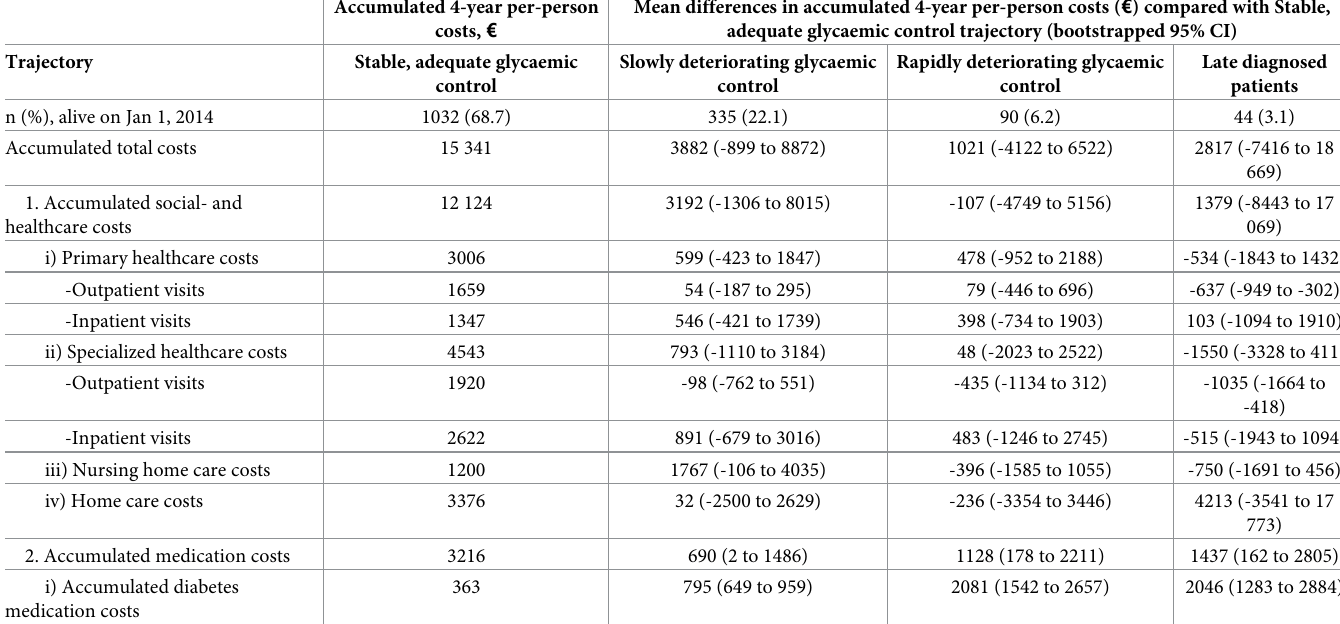
Table 3. Absolute accumulated 4-year per-person healthcare costs (euros, € ) for the Stable, adequate glycaemic control trajectory. Mean differences in accumulated 4-year per-person healthcare costs between HbA1c trajectories with bootstrapped 95% confidence intervals (Stable, adequate glycaemic control trajectory as a reference). All costs are Kaplan-Meier sample average adjusted and calculated for